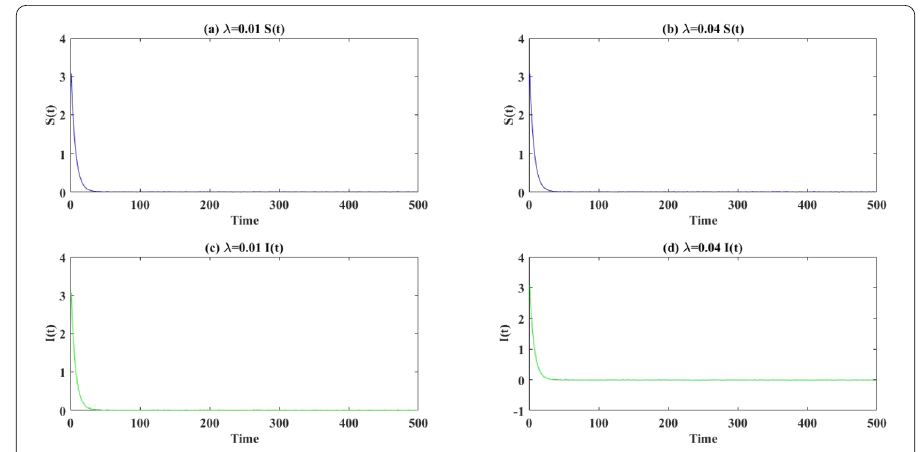
Figure 3 Examples of Theorem 3.3. The dynamics of system (44) are shown with parameter values as described in the text, and (left column) λ = 0.01, m 1 = 0.8 and m 2 = 0.25 (right column) λ = 0.04, m 1 = 0.9 and m 2 =